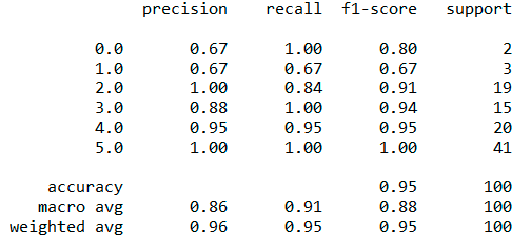
Figure 3. Correlation heatmap and classification accuracy of ML models to classify “BMI” data.